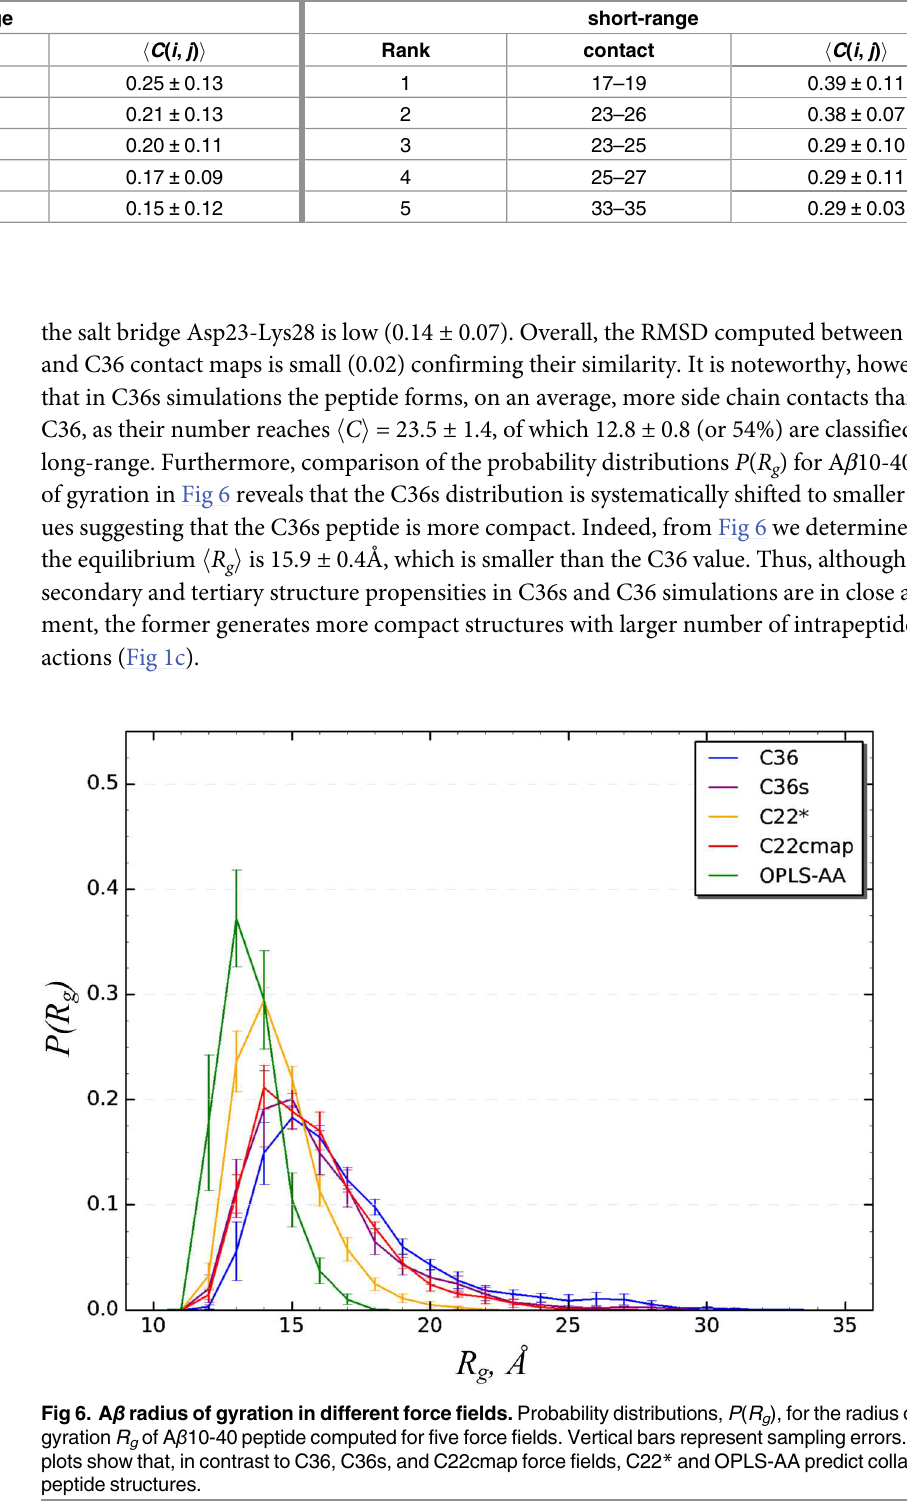
Table 2. Five top side chain contacts in A β 10-40peptide for C36 force field.